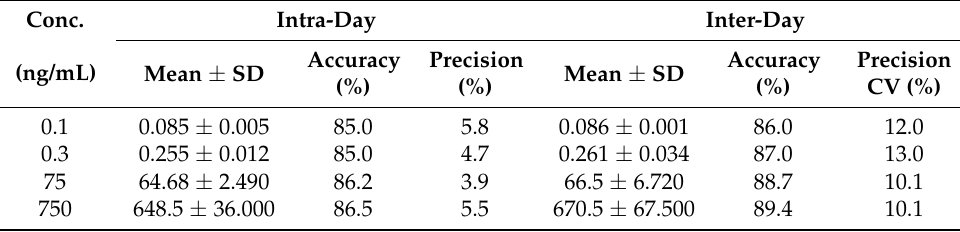
Table 2. Inter- and Intra-day Precision and Accuracy of Measurements of Tamatinib in Rat Plasma. Conc.